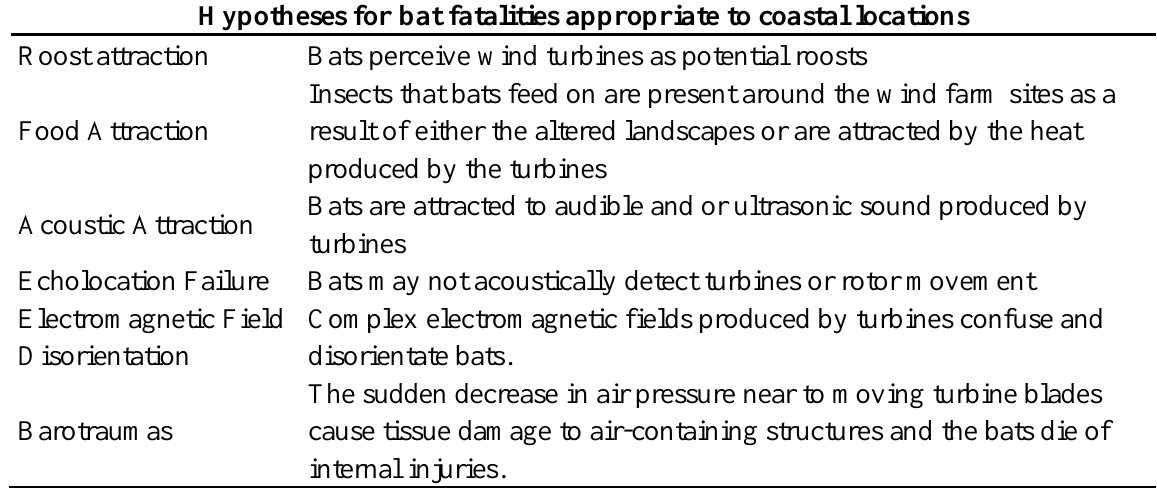
Table 6. Possible reasons for bat fatalities associated with wind turbines (adapted from Kunz et al ,